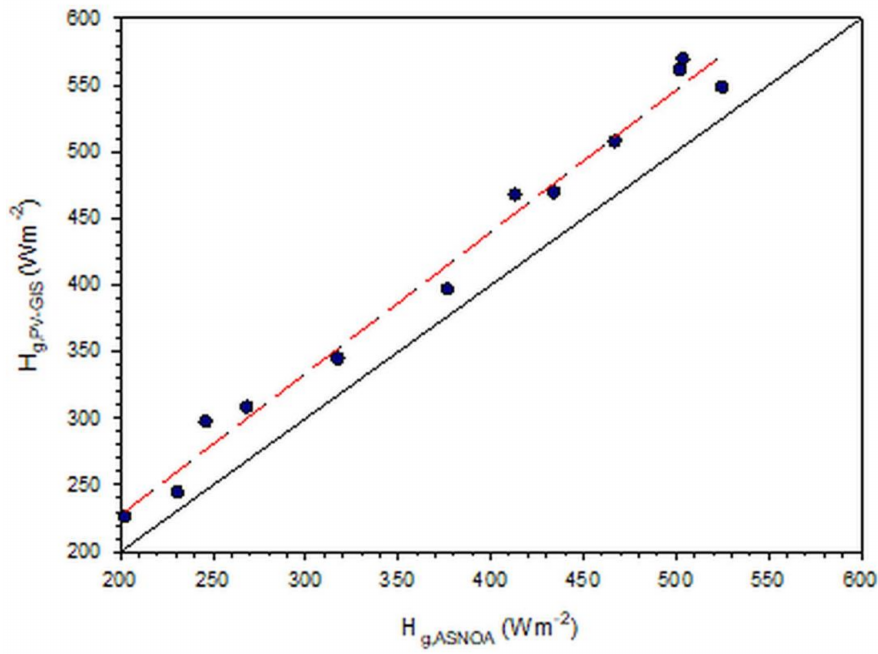
Figure 10. Comparison of monthly mean solar energy values from PV-GIS, H g,PV-GIS , to measured ones at ASNOA, H g,ASNOA , in the period 2005–2011. The red dashed line represents the best fit to the data points and is expressed by the regression equation: H g,PV-GIS = 1.06 · H g,ASNOA + 14.96 (R 2 = 0.99). The solid black line is the 1:1 (or y = x ) line. This figure is a reproduction of Figure 8 in [1] and Figure 9 in